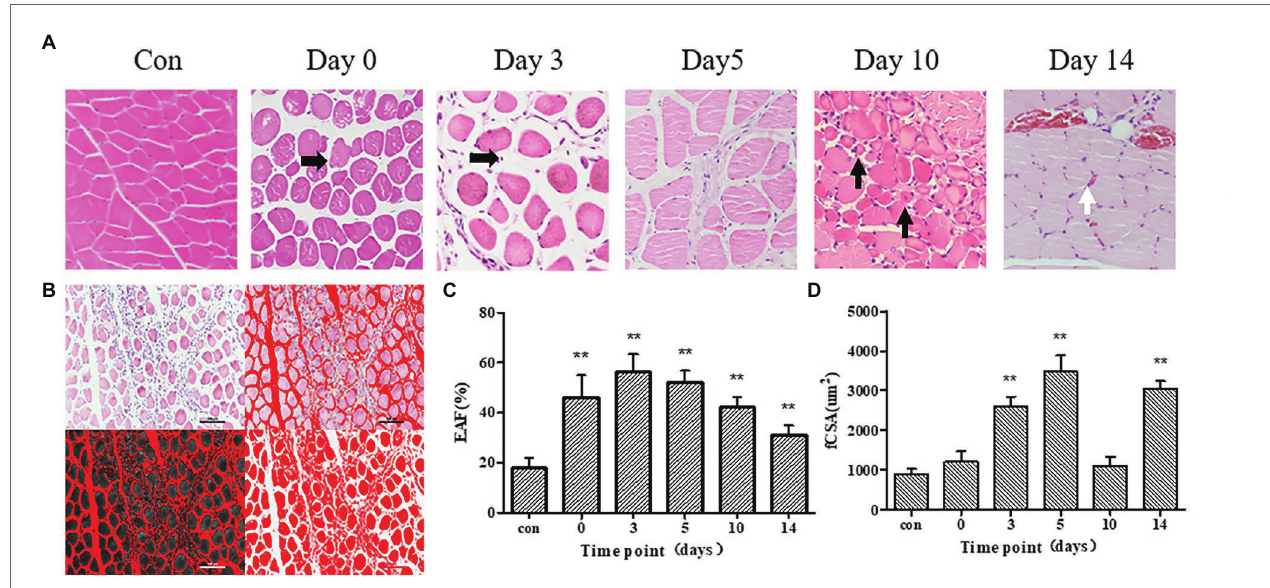
FIGURE 3 | (A) Hematoxylin-eosin (HE) stained images in control group, 0, 3, 5, 10, and 14 days after frostbite. Damaged skeletal muscle tissue exhibits diffuse swelling of muscle cells or inflammatory cells infiltration (Horizontal black arrow). On day 10, regenerated skeletal muscle (Vertical black arrow) was observed. On day 14, red blood cells (white arrows) can be observed in muscle tissue. (B) This example shows how to measure the fiber cross-sectional area (fCSA) and extracellular area fraction (EAF). (C,D) : EAF and fCSA of control group and frostbite groups. Scale bar, 200 μ m. EAF, extracellular matrix area fraction; fCSA, fiber cross-sectional area. ** p <